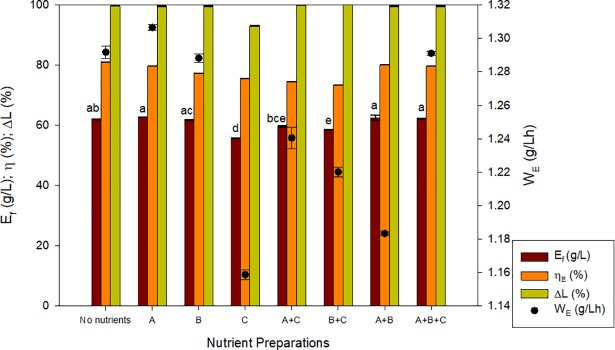
Evaluation of the effect of different combinations of nutrients on alcoholic fermentation performance.Response variables: Ethanol final concentration (Ef), ethanol yield conversion efficiency (ηE), lactose consumption (ΔL) and productivity (WE) of K. marxianus 5422 employing concentrated CWP (Li = 130 g/L). Description of nutrient preparations: A (3 g/L yeast extract, 2 g/L NH4Cl, 2 g/L KH2PO4, and 2 g/L K2HPO4), B (1 g/L MgSO4·7H2O), C (200 mg/L sodium thioglycolate). The different letters above ethanol bars (a, b, c, d, e) indicate the existence of significant differences (p < 0.05) among samples for ethanol production. If two samples share one letter, there are no significant differences between them.